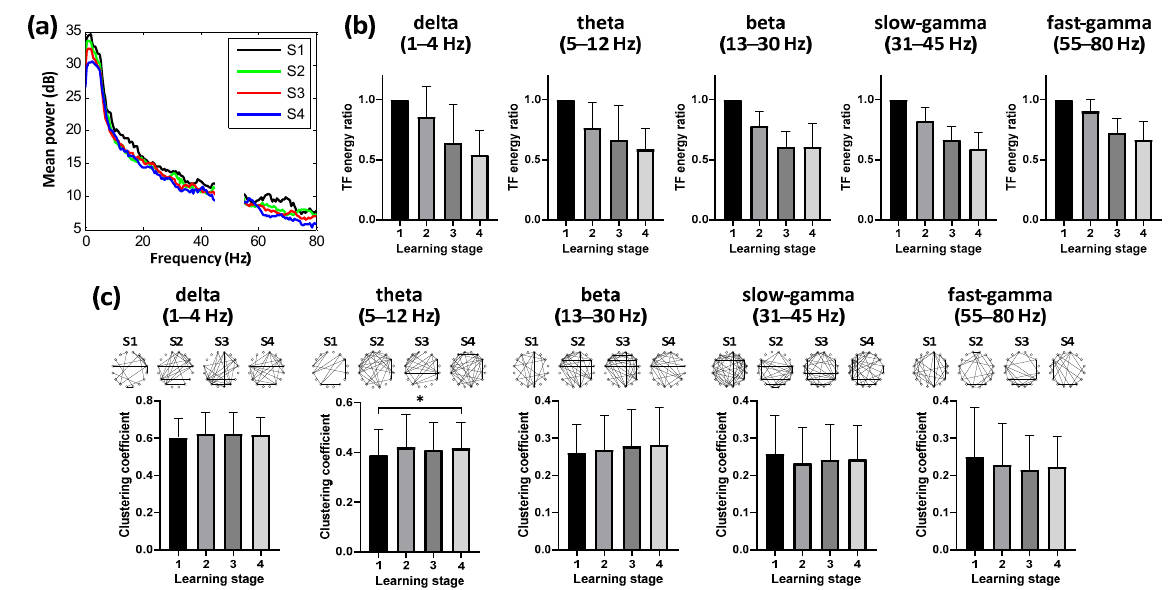
Figure 3. Dynamics of hippocampal activity during learning ( n = 6 animals, 16 sessions ) . ( a ) Power spectral density in Hp during route formation of spatial learning. ( b ) Mean time–frequency (TF) energy changes in different bands relative to stage 1 for Hp. Data are presented as mean ± std. ( c ) Binarized hippocampal functional networks (Top, examples of the pigeon numbered P100) and statistical clustering coefficient results of the networks (Bottom, population data of all pigeons) for different bands across learning stages (* p < 0.05; Friedman ANOVA). Data are presented as mean ± std. S1 represents the learning stage 1, and so forth.